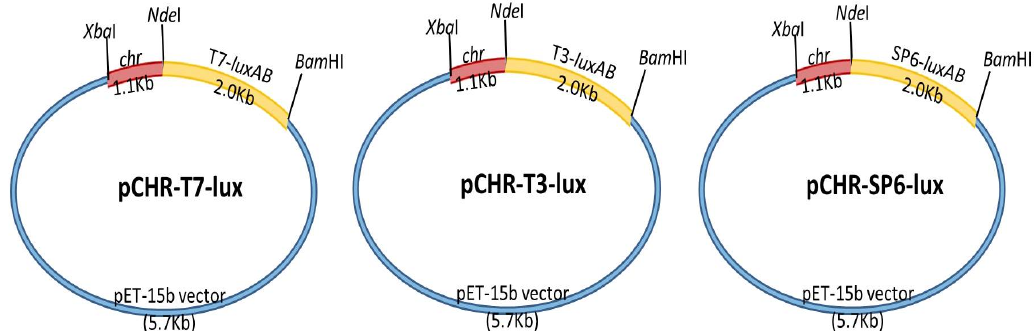
Figure 1. Construction of pCHR-T7-luxAB, pCHR-T3-luxAB, and pCHR-SP6-luxAB plasmids.